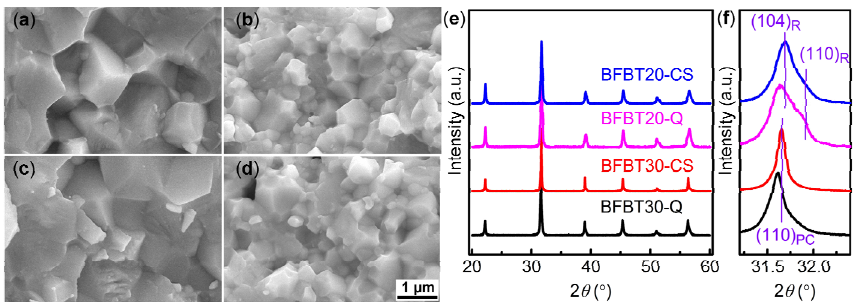
Fig. 1 Morphology and structure properties of BFBT100 x ceramics. (a–d) Fracture surface images of BFBT20-CS, BFBT20-Q, BFBT30-CS, and BFBT30-Q ceramics, respectively; (e) XRD patterns of four ceramics; (f) the enlarged view of the peaks near